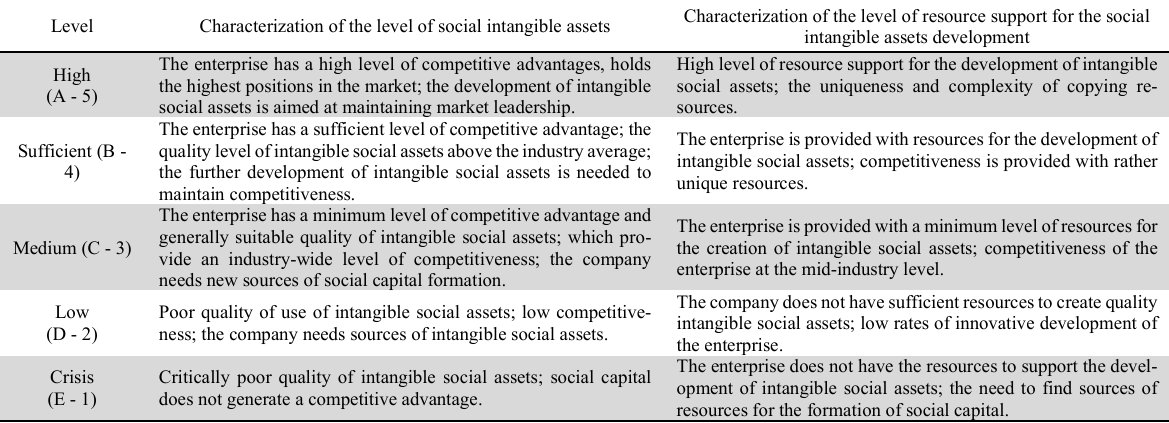
Levels of social intangible assets